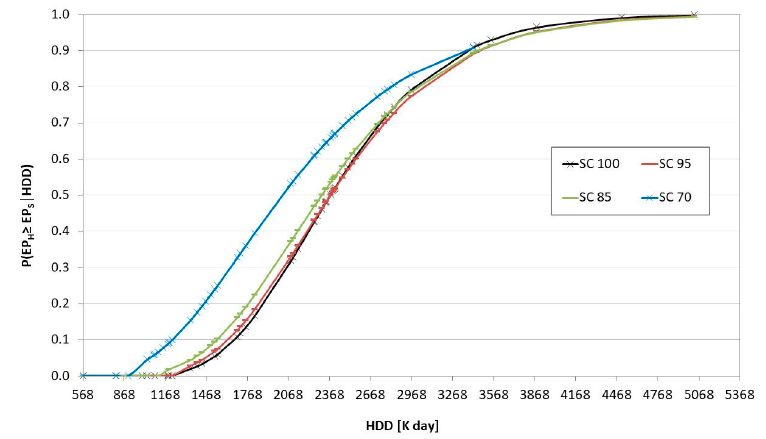
Figure 10. Energetic fragility curves—4-storey building.